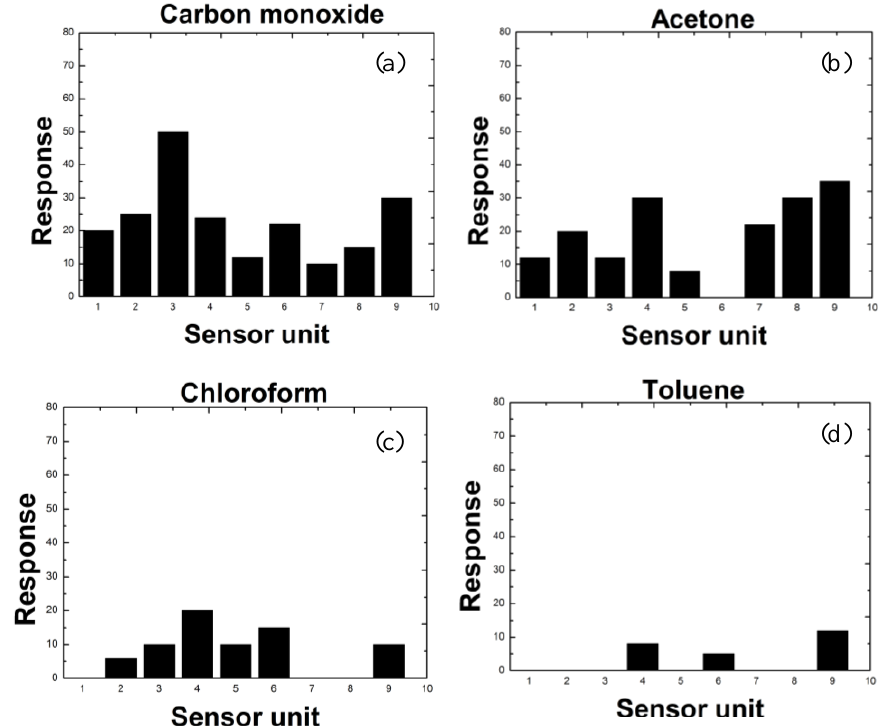
Figure 5. Brightness histograms obtained from CTL patterns of carbon monoxide, acetone, chloroform and toluene on each sensing element of the array. Concentration of all compounds: 1000 ppm, working temperature: 240 °C, carrier gas flow rate: 200 mL/min.